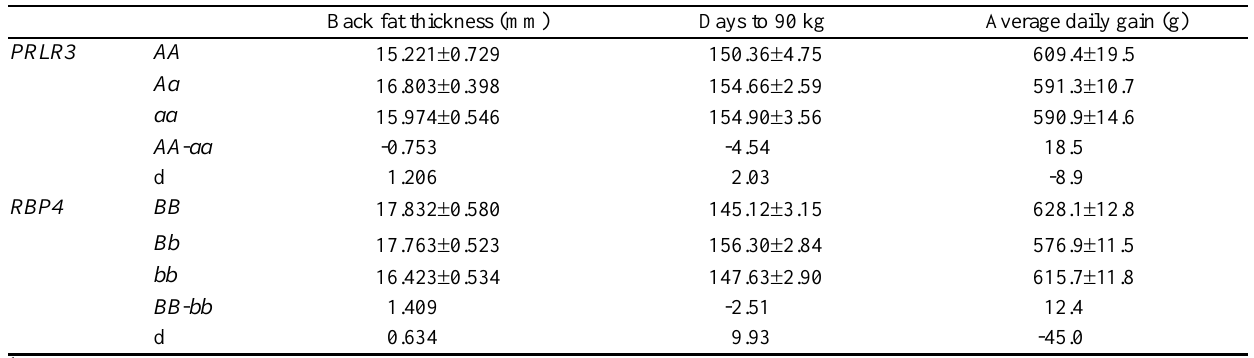
Table 8. Additive and dominant (d) genetic effects of PRLR3 and RBP4 genes in production traits 1